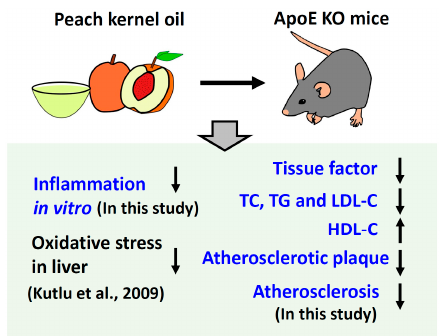
Figure 5. Schematic representation of the obtained results and the protective effects of peach kernel oil to reduce Atherosclerosis in ApoE knockout Mice. The results obtained from this study are highlighted in blue color. The result obtained from previous study [18] is highlighted in black color.